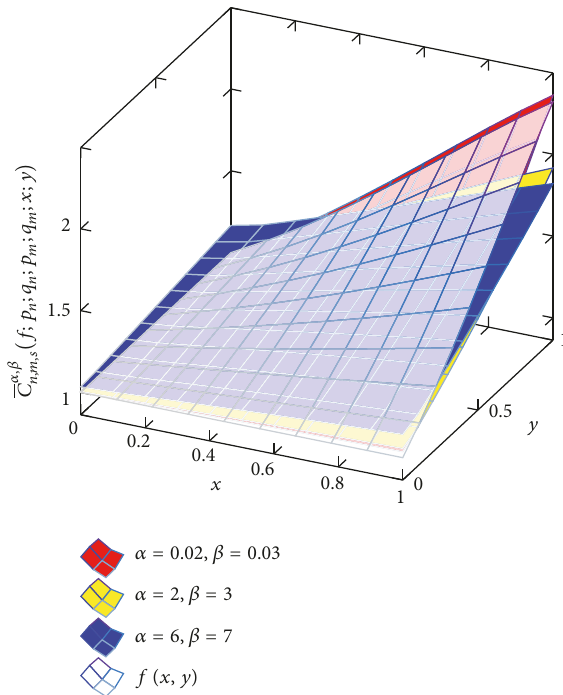
𝛼,𝛽 (𝑓;𝑝 , 𝑞 ,𝑝 ,𝑞 ; 𝑥,𝑦) to multivari- 𝑛 𝑛 𝑚 𝑚 𝑛,𝑚,𝑠